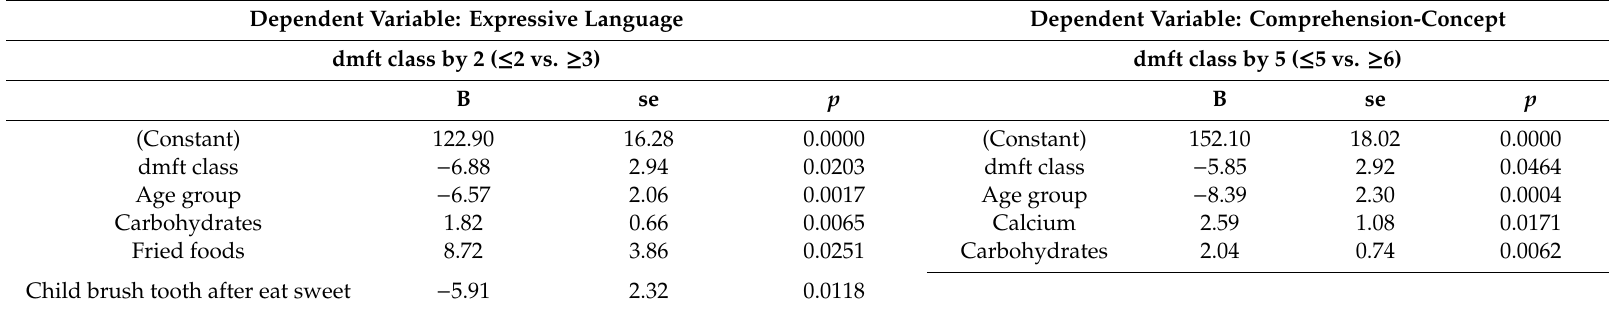
Table 4. The regression model computed for their relationships detected between all variables and psychomotor